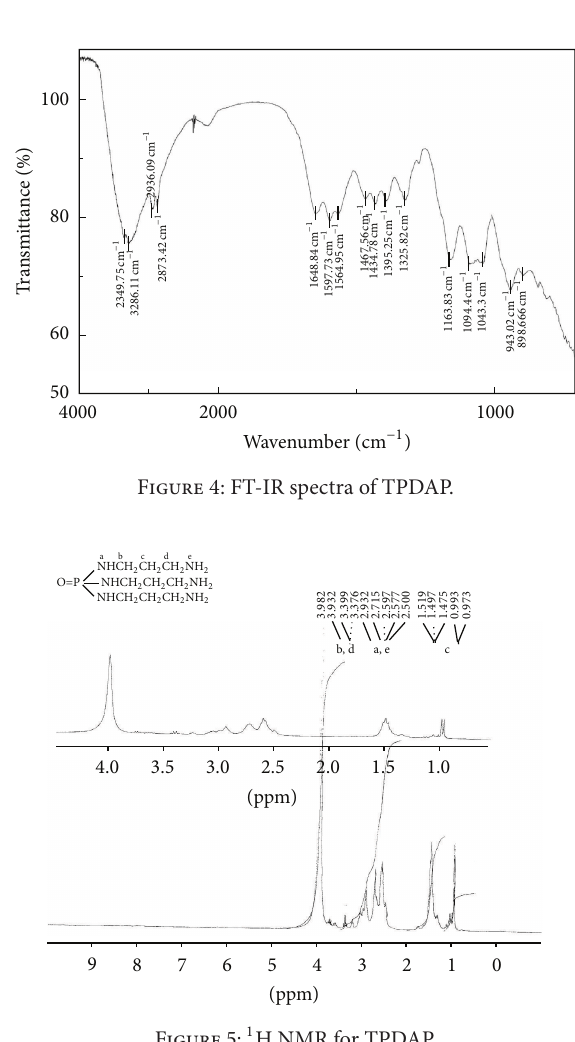
Figure 5: 1 H NMR for TPDAP.